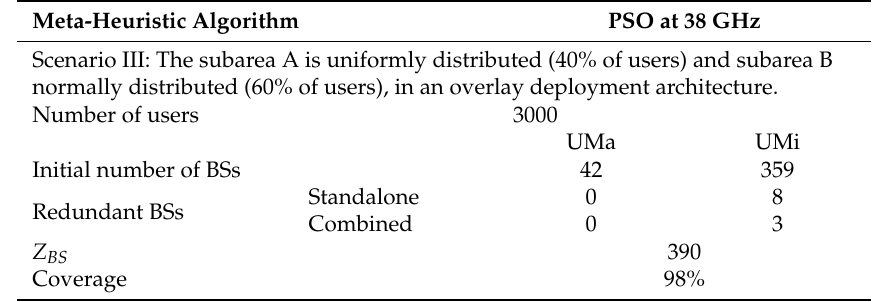
Table 6. Performance evaluation in different user distribution for 5G network planning at 38 GHz. Meta-Heuristic Algorithm